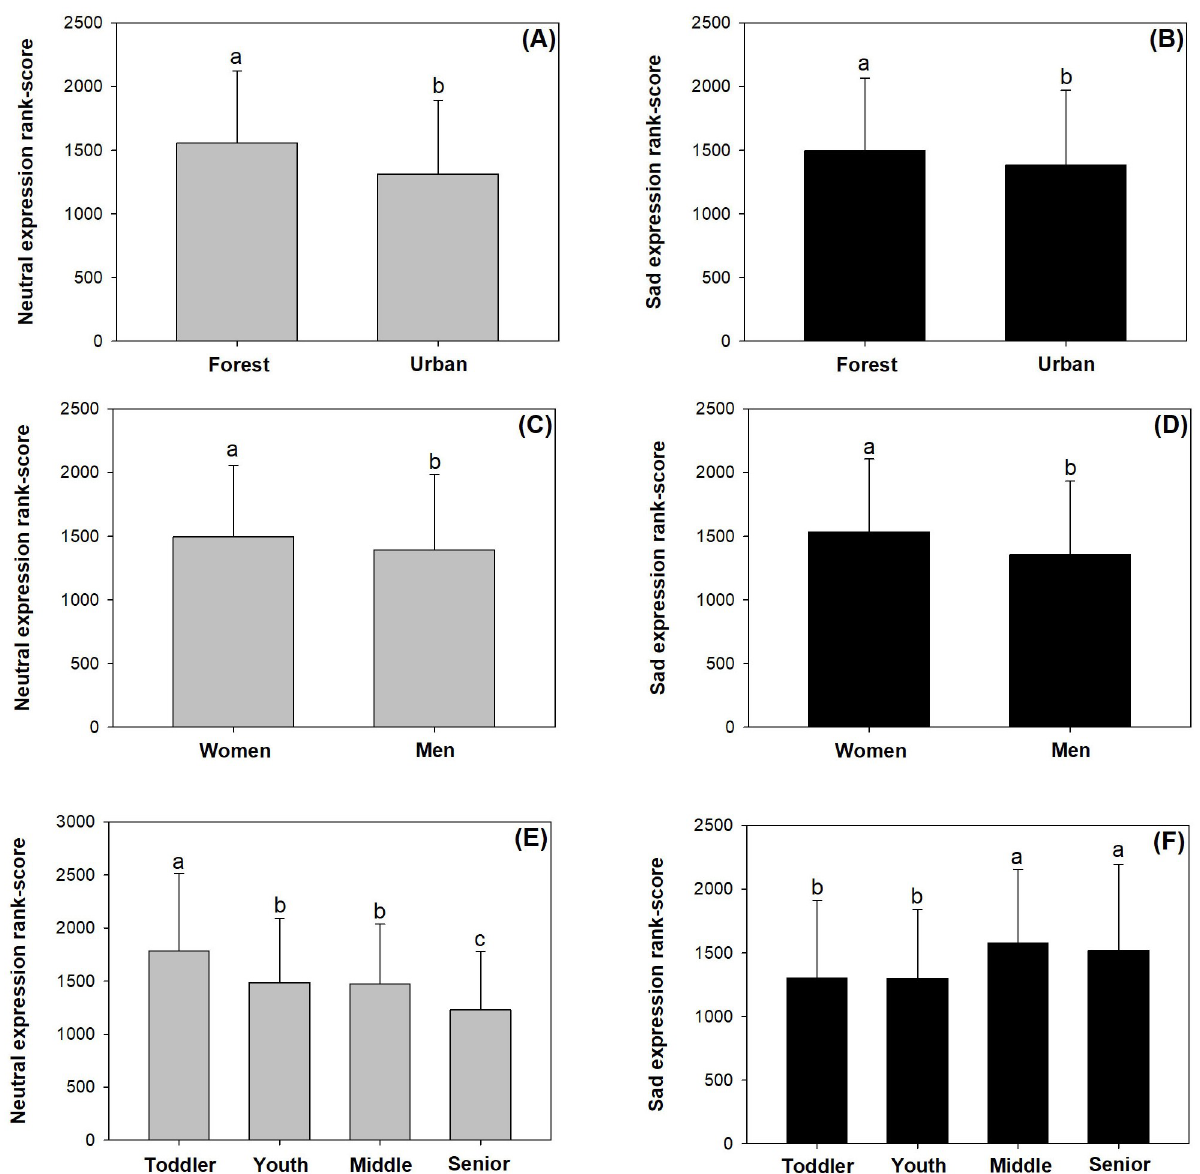
Fig 5. Neutral and sad scores with variations by location (forest vs urban), gender (men vs women), and age (toddler, youth, middle, senior). Scores have been transformed by ranking. Bars stand for standard errors. Different letters indicate significant difference according to Duncan test at 0.05